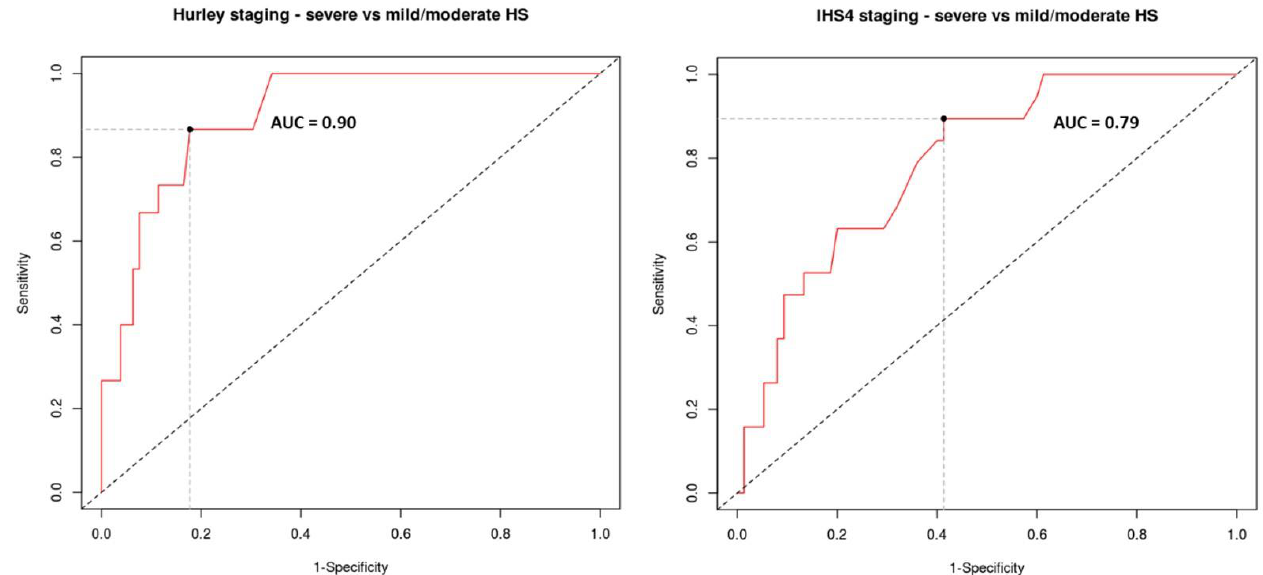
Figure 3. Serum IgG levels demonstrate a strong discriminatory capacity to identify HS patients with Hurley stage 3 disease from stage 1 and 2 disease (left, AUC 0.9) and a moderate discriminatory capacity (AUC 0.79) to identify HS patients with IHS4 “ severe ” disease from patients with mild and moderate disease as classified by IHS4. Youden’s index is indicated by the filled circle. AUC = area under the curve.